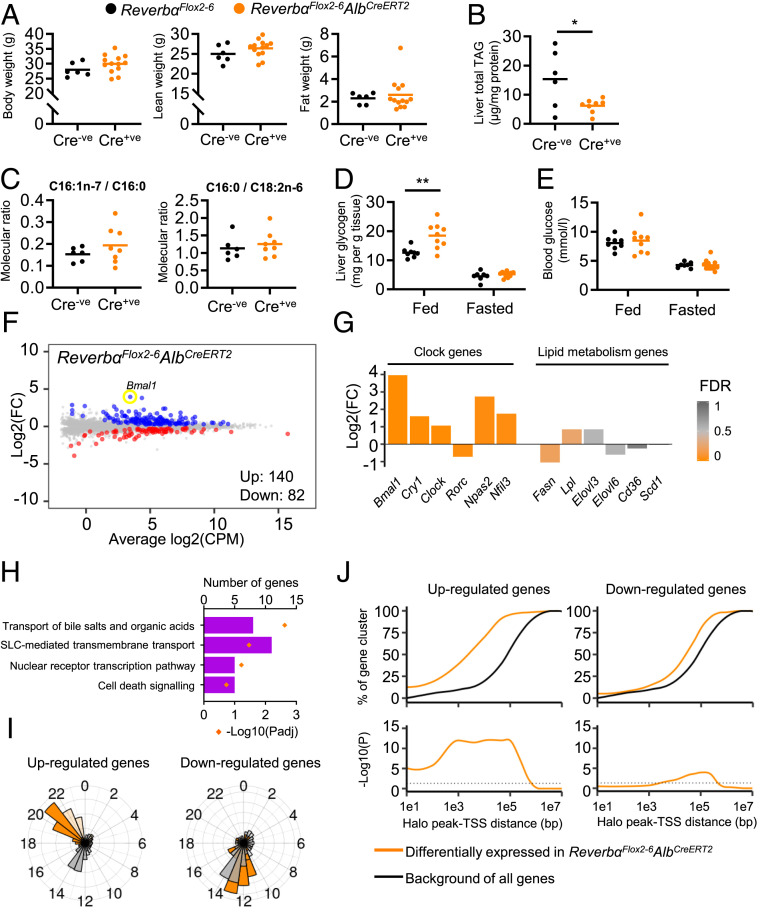
Liver-targeted Reverbα deletion and HaloREVERBα ChIP-seq define direct REVERBα targets. (A) No genotype differences in body weight, lean, and fat mass were observed between ReverbαFlox2-6AlbCreERT2 mice and ReverbαFlox2-6 littermate controls (12- to 14-wk-old males, n = 6 to 13 per group, 15 d after the first tamoxifen injection [10 d after the last]). (B and C) ReverbαFlox2-6AlbCreERT2 mice do not accumulate liver lipid. Quantification of total liver triacylglyceride (TAG) (B) and fatty acid composition analysis (C) show diminished TAG levels in ReverbαFlox2-6AlbCreERT2 liver (compared to controls) and no differences in fatty acid desaturation (reflected by C16:1n-7/C16:0 ratio) or de novo lipogenesis (reflected by C16:0/C18:2n ratio). (n = 6 to 8 per group, 12- to 14-wk-old males and females, 15 d after the first tamoxifen injection). (D and E) Liver-specific deletion of REVERBα has some effect on carbohydrate metabolism, as shown by increased liver glycogen in the fed state in ReverbαFlox2-6AlbCreERT2 mice (D), but no differences in blood glucose levels (E) (n = 7 to 12 per group, 12- to 14-wk-old males and females, 15 d after the first tamoxifen injection). (F) Mean difference (MD) plot of liver RNA-seq from ReverbαFlox2-6AlbCreERT2 male mice (relative to littermate controls); genes with significant differential expression (FDR < 0.05) highlighted in color (up-regulated in blue, down-regulated in red). (G) Circadian clock, but not lipid metabolism genes are differentially expressed (DE) in the livers of ReverbαFlox2-6AlbCreERT2 mice compared to controls (fold change [FC] and FDR of selected clock and lipid metabolism genes from F). (H) Reactome pathway analysis of significantly DE genes does not show enrichment of lipid metabolism pathways. Four pathways with lowest Padj values are shown. Full results are in SI Appendix, Table S6. (I) Phase plots of rhythmic, differentially expressed genes identified in ReverbαFlox2-6AlbCreERT2 livers (orange), with all rhythmic genes in liver shown in gray. Gene rhythmicity and peak phase (acrophase) were taken from ref. 32. Introns are in darker bars, exons in lighter bars. (J) Proximity of differentially expressed genes to HaloREVERBα peaks. (J, Top) Proportion of each gene set lying within a given distance of peaks. (J, Bottom) Significance of the enrichment of each gene set compared to all genes in the genome at each distance. Individual data points are shown, line at mean, *P < 0.05, **P < 0.01, unpaired t test (A–C). Two-way ANOVA with Tukey’s multiple comparisons tests (D and E).